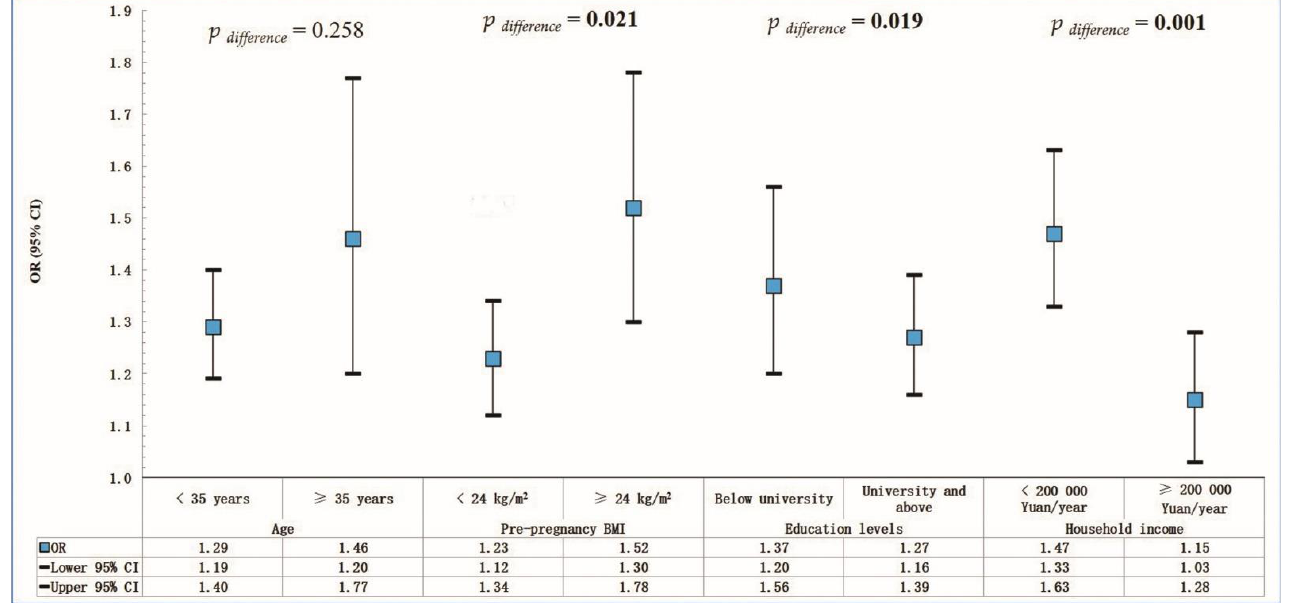
Figure 2. Adjusted odds ratios (ORs) and 95% confidence intervals (CIs) of associations between pet ownership and threatened abortion, stratified by potential modifiers. Adjusted for average daily working hours, ethnicity, educational levels, average annual household income, and house types.